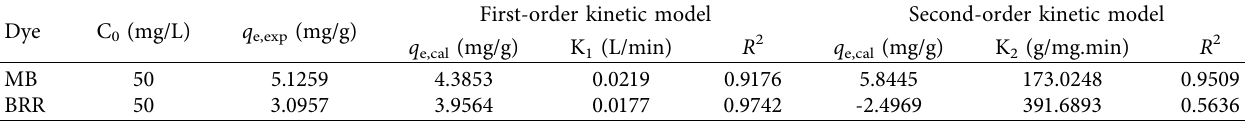
Table 4: Comparison of first-order and second-order adsorption rate